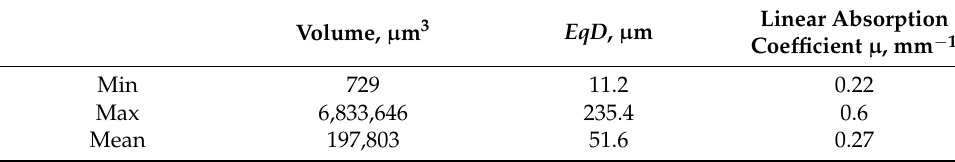
Table 1. Quantitative parameters of the microinclusions.